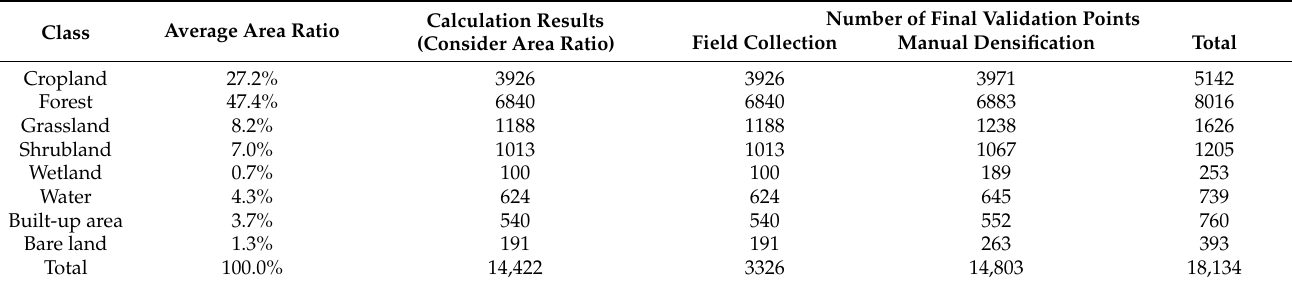
Table 7. Calculation results of the number of the final validation points